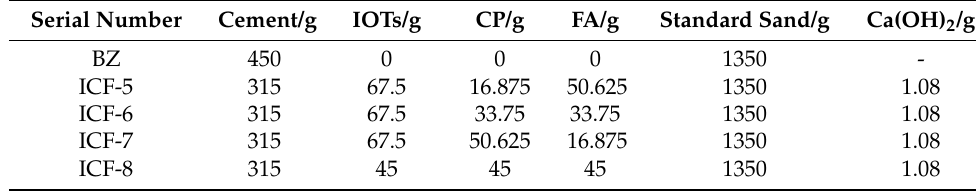
Table 4. Cement mortar ratio of group B.